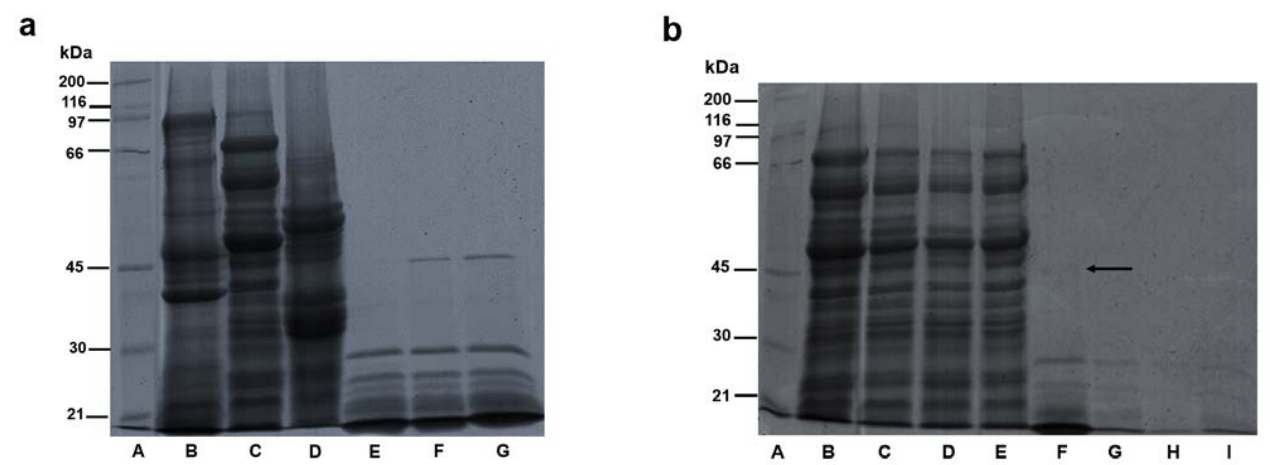
Figure 3. ( a ) SDS-PAGE profile of chickpea protein concentrates and hydrolysates. Lane A: molecular weight marker; lane B: Al; lane C: Gb; lane D: Gt; lane E: HAl; lane F: HGb; lane G: HGt. ( b ) SDS-PAGE profile of globulin concentrates, and hydrolysates pretreated with pulsed ultrasound. Lane A: molecular weight marker; lane B: Gb; lane C: Gb-10; lane D: Gb-20; lane E: Gb-30; lane F: HGb; lane G: HGb-10; lane H: HGb-20; lane I: HGb - 30.